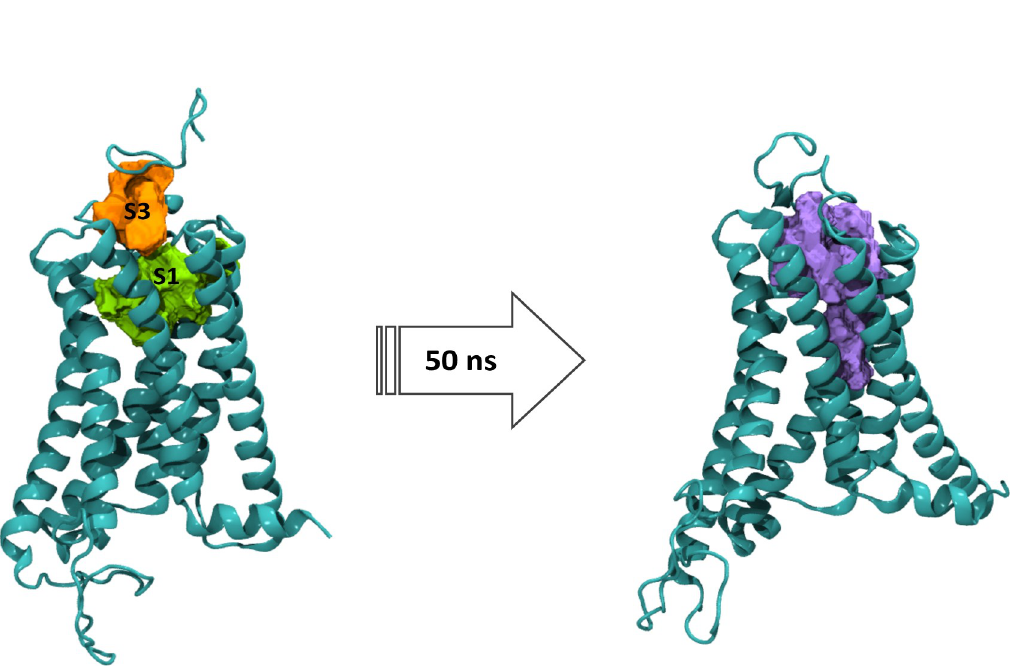
Fig 9. Changes in the binding sites S1and S3 in the active conformation of the CB 1 R after 50 ns of simulation. Orthosteric site S1 (green), allosteric site S3 (orange) and combined pocket